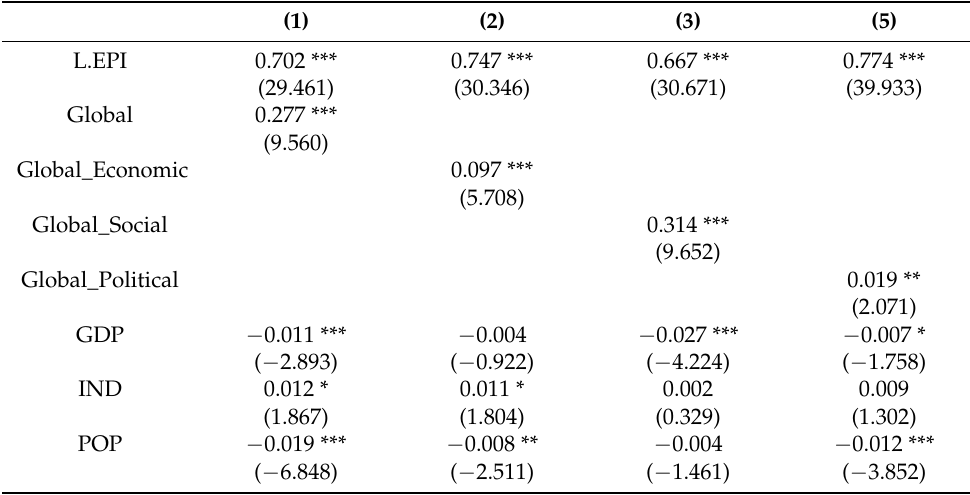
Table 7. Robustness test—Middle 80%